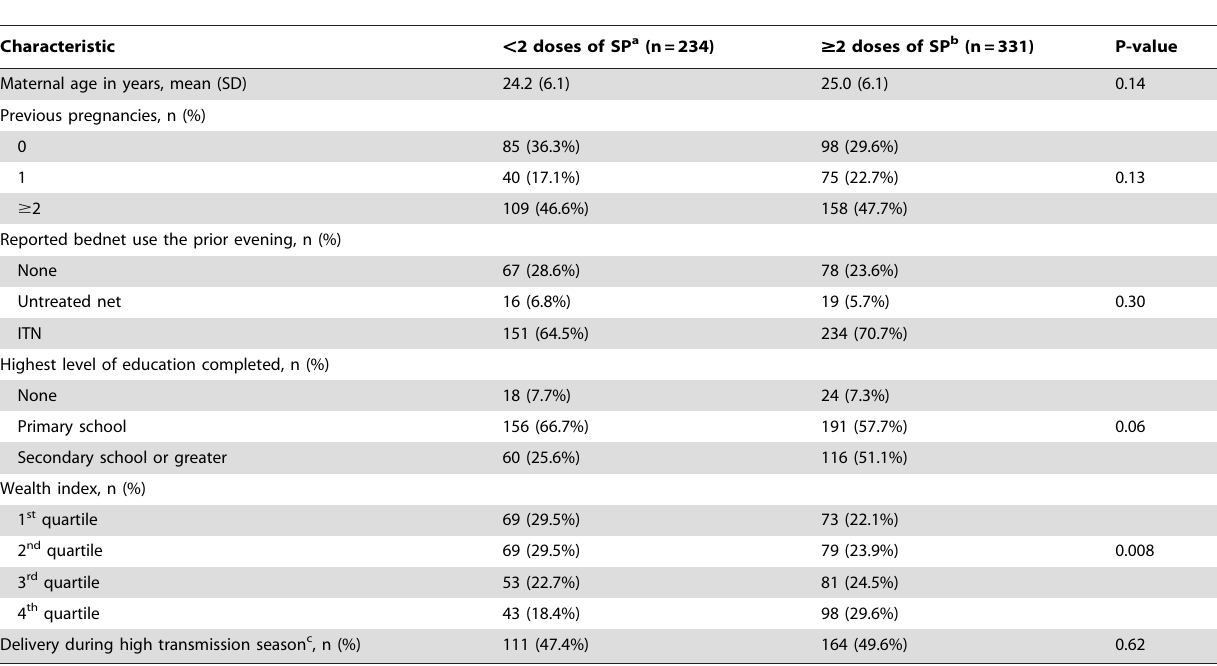
Table 1. Characteristics of study participants stratified by number of SP doses reported